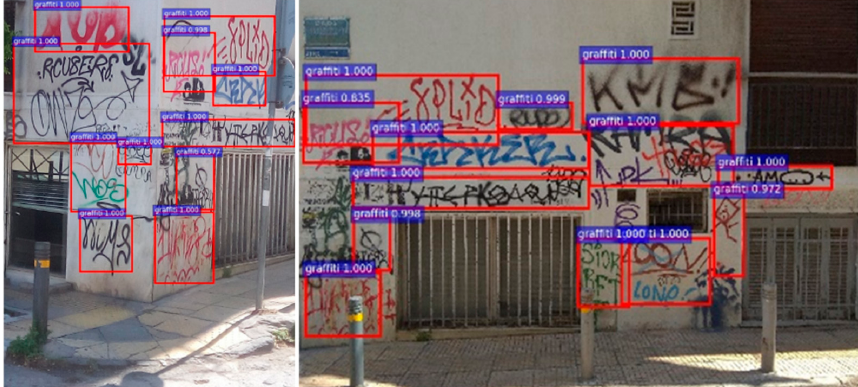
Table 1. Confusion matrix for calculating the accuracy of the trained R-CNN.